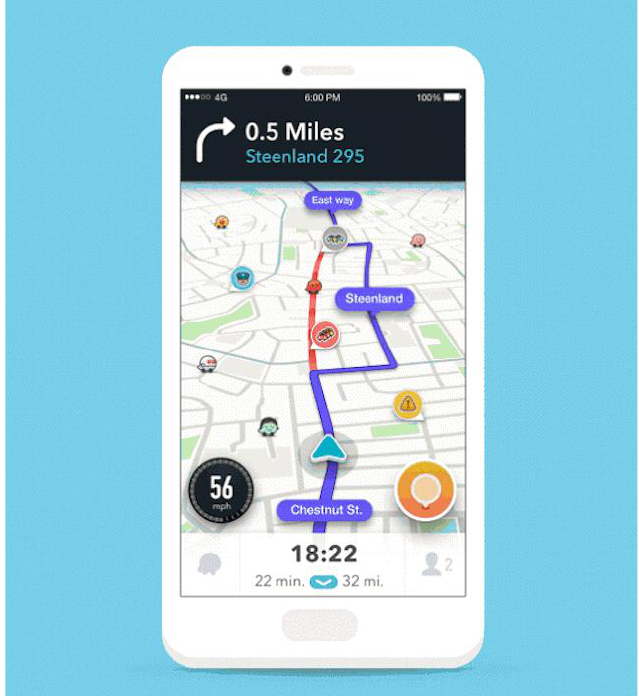
Figure 4: Waze interface. Analyzing the volume of traffic and speed limit, Waze shows fastest route for navi- gation. (Source: